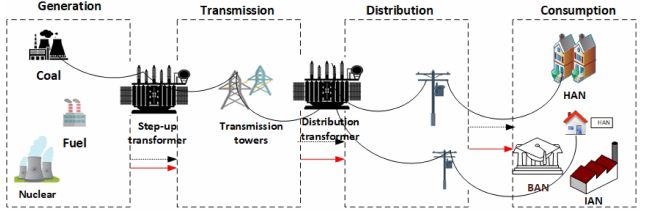
Figure 3. General representation of legacy power grids "Reprinted/adapted with permission from Ref. [3]. 2020,